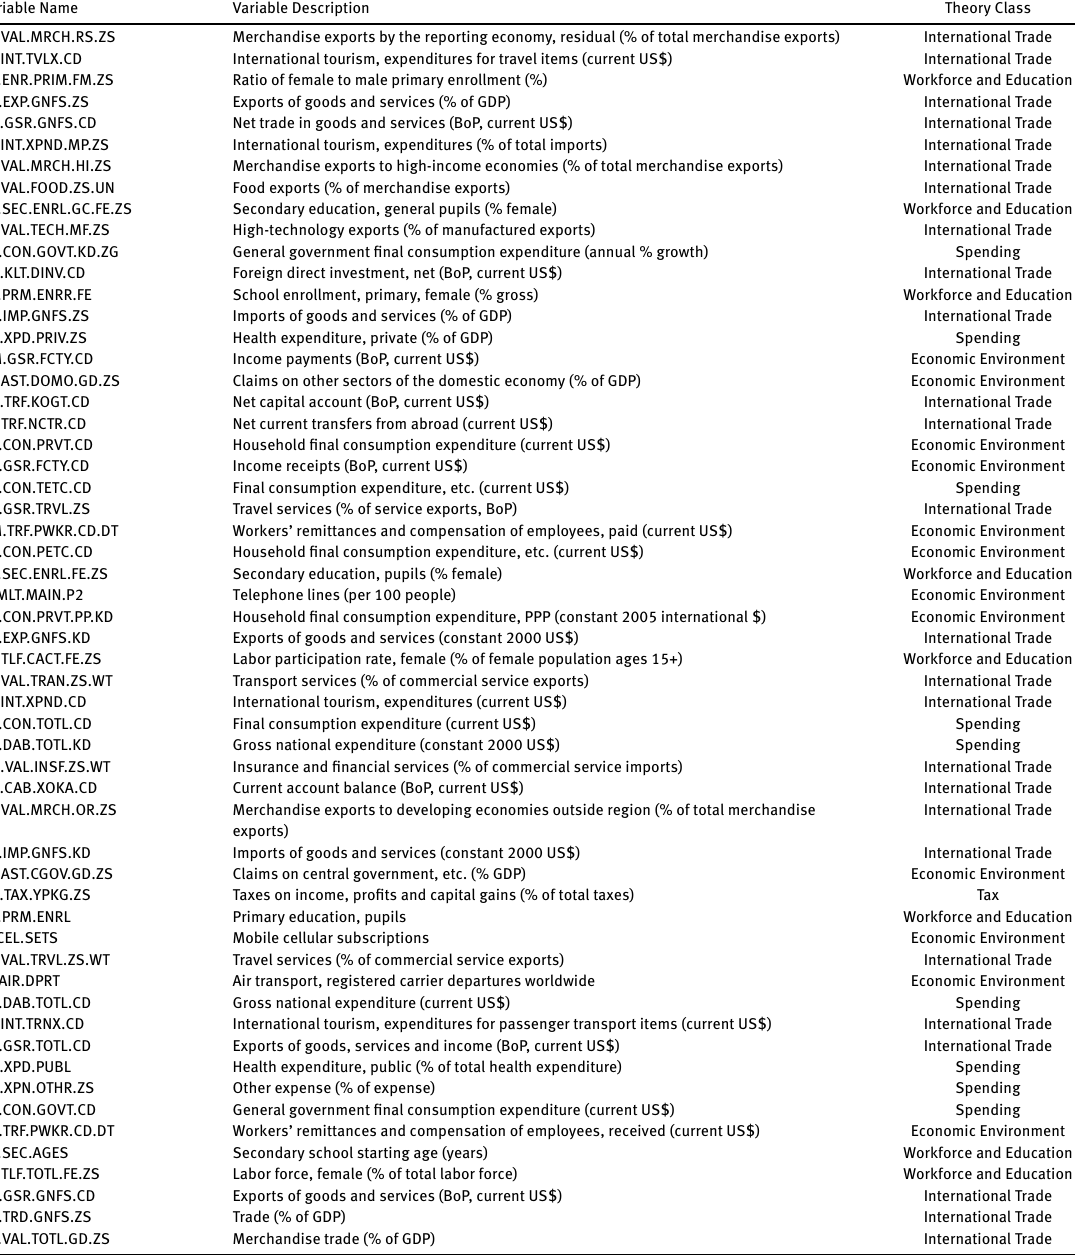
Table 11: List of Applied Risk Indicators